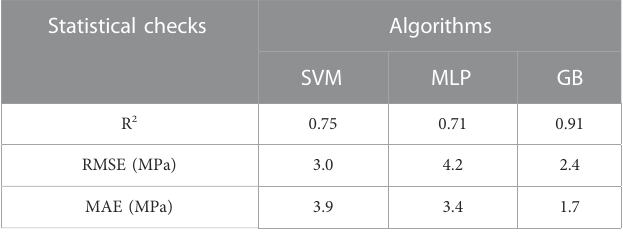
TABLE 1 Statistics derived from the employed models.